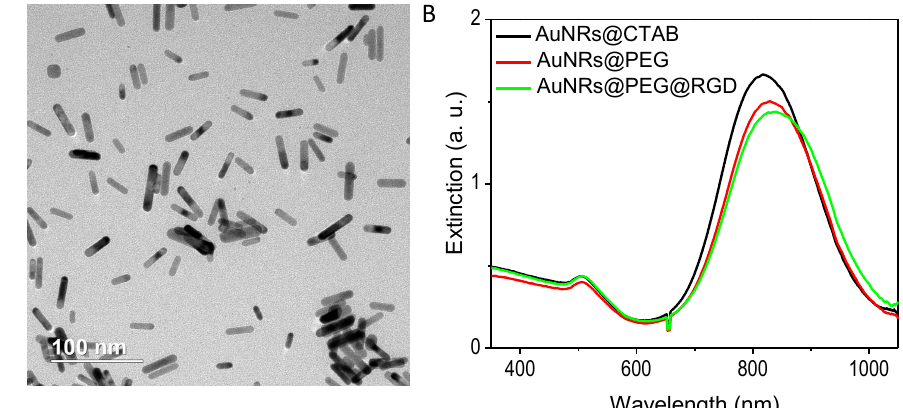
Figure 1. Characterization of gold nanorods (length 27 ± 5 nm, width 6 ± 1 nm). ( A ) Transmission